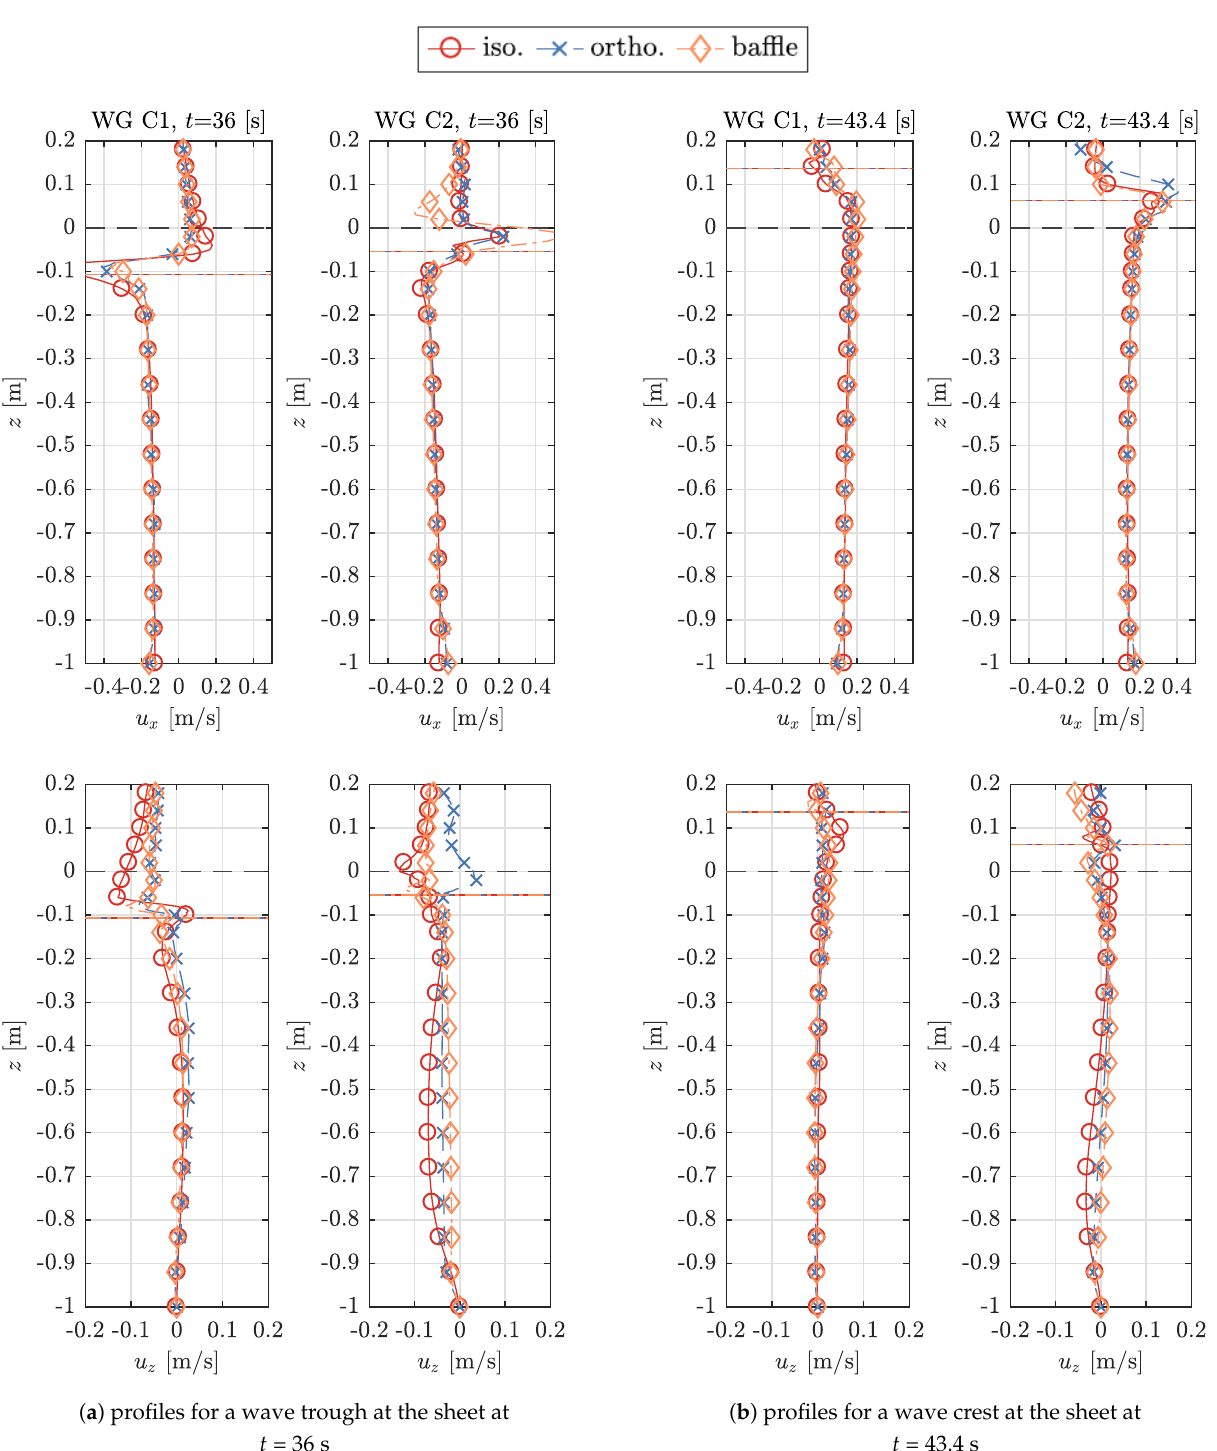
Figure 11. Velocity profiles in horizontal, u x , and vertical, u z , direction 0.1 m before (WG C1) and 0.1 m after (WG C2) the sheet for a wave trough and crest at the sheet. ( a ) profiles for a wave trough at the sheet at t = 36 s ( b ) profiles for a wave crest at the sheet at t = 43.4